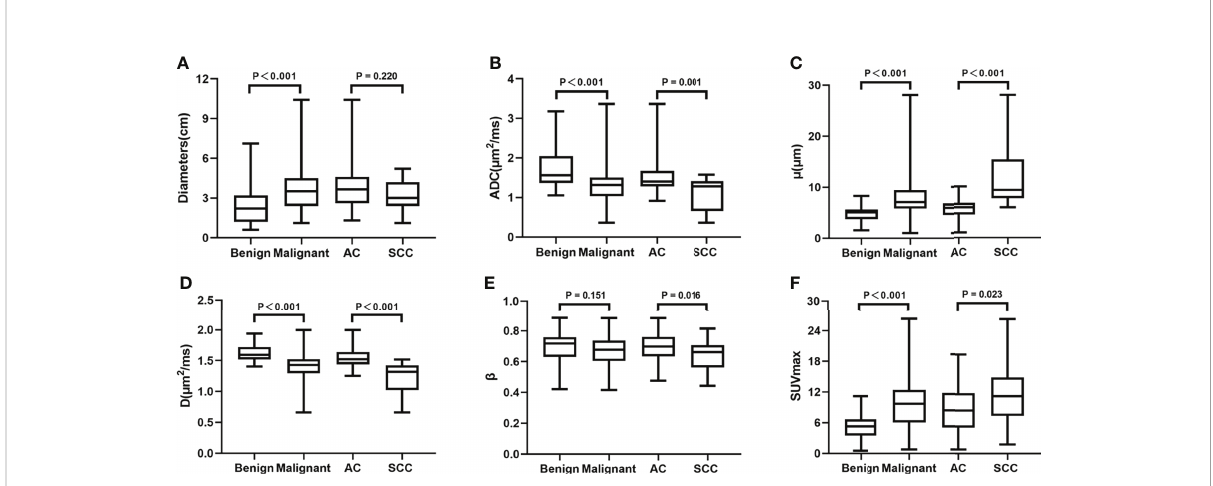
FIGURE 4 Boxplots of Diameters, ADC, m , D, b and SUVmax between the benign and malignant SPLs groups, and between AC and SCC groups. ADC, apparent diffusion coef fi cient; D, diffusion coef fi cient; SCC, squamous cell carcinoma; SUVmax, maximum value of standard uptake value.